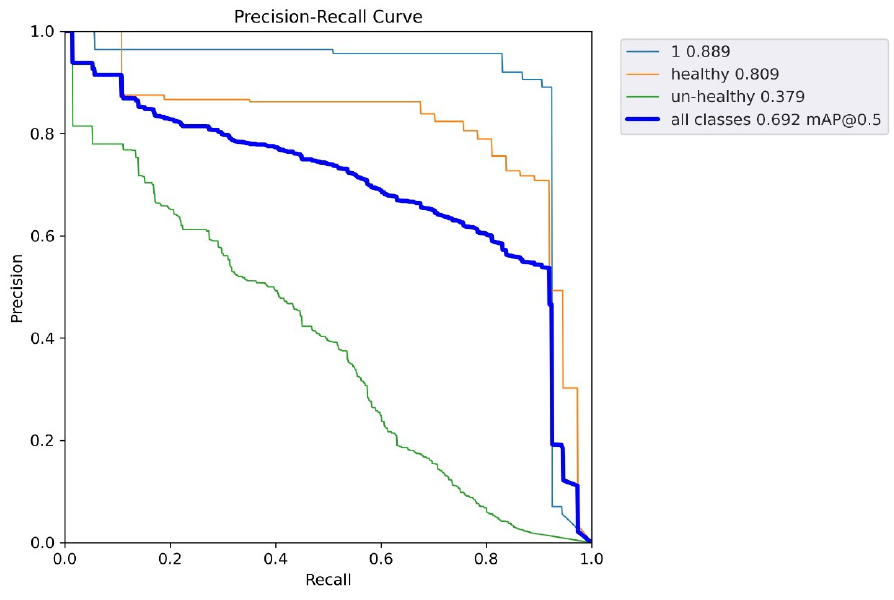
Figure 29. Precision according to recall graph:The precision via recall graph represents both high recall and high